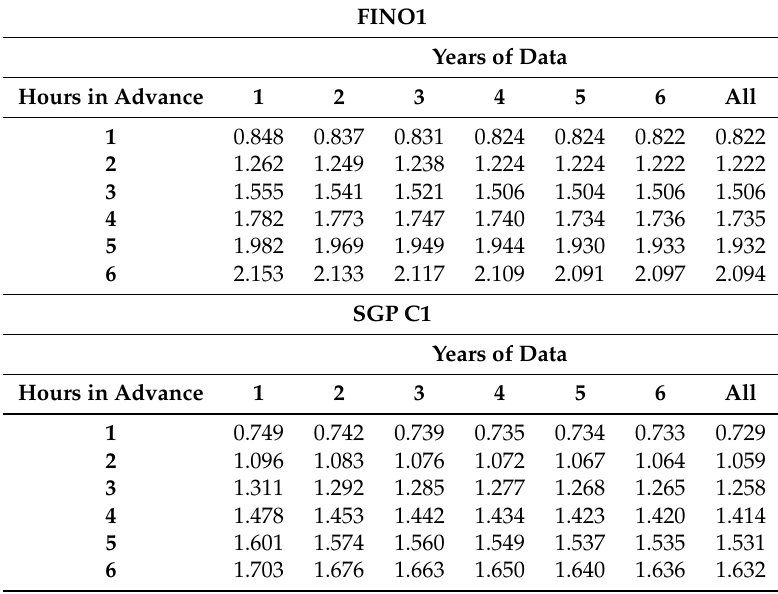
Table A3. RMSE (m s − 1 ) obtained by the DE strategy given varying amounts of training data when forecasting hourly wind speed one to six hours in